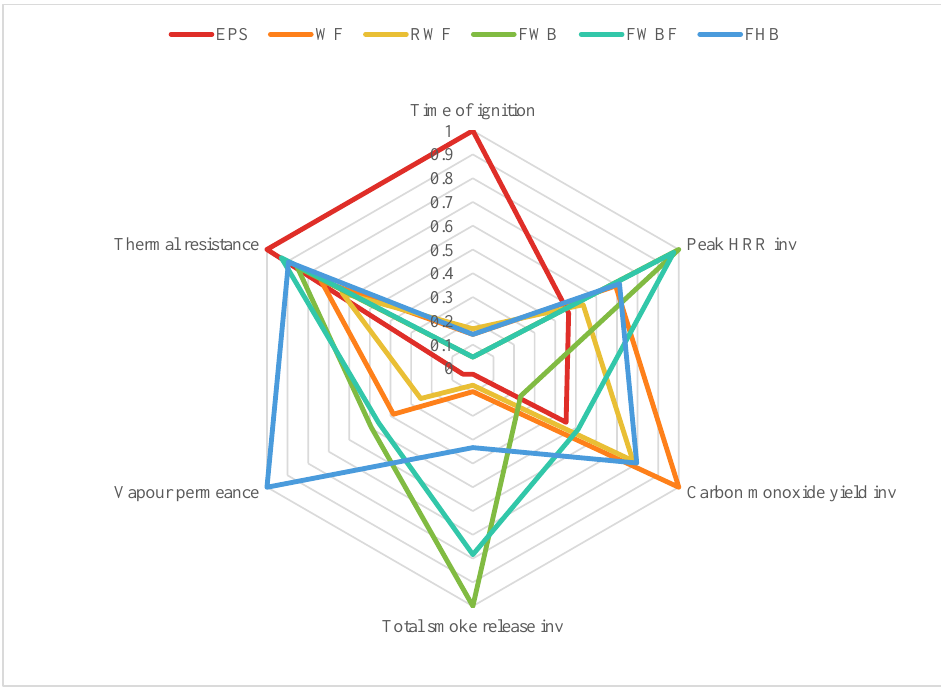
Figure 5. Relative assessment of the attributes of the studied insulation materials.